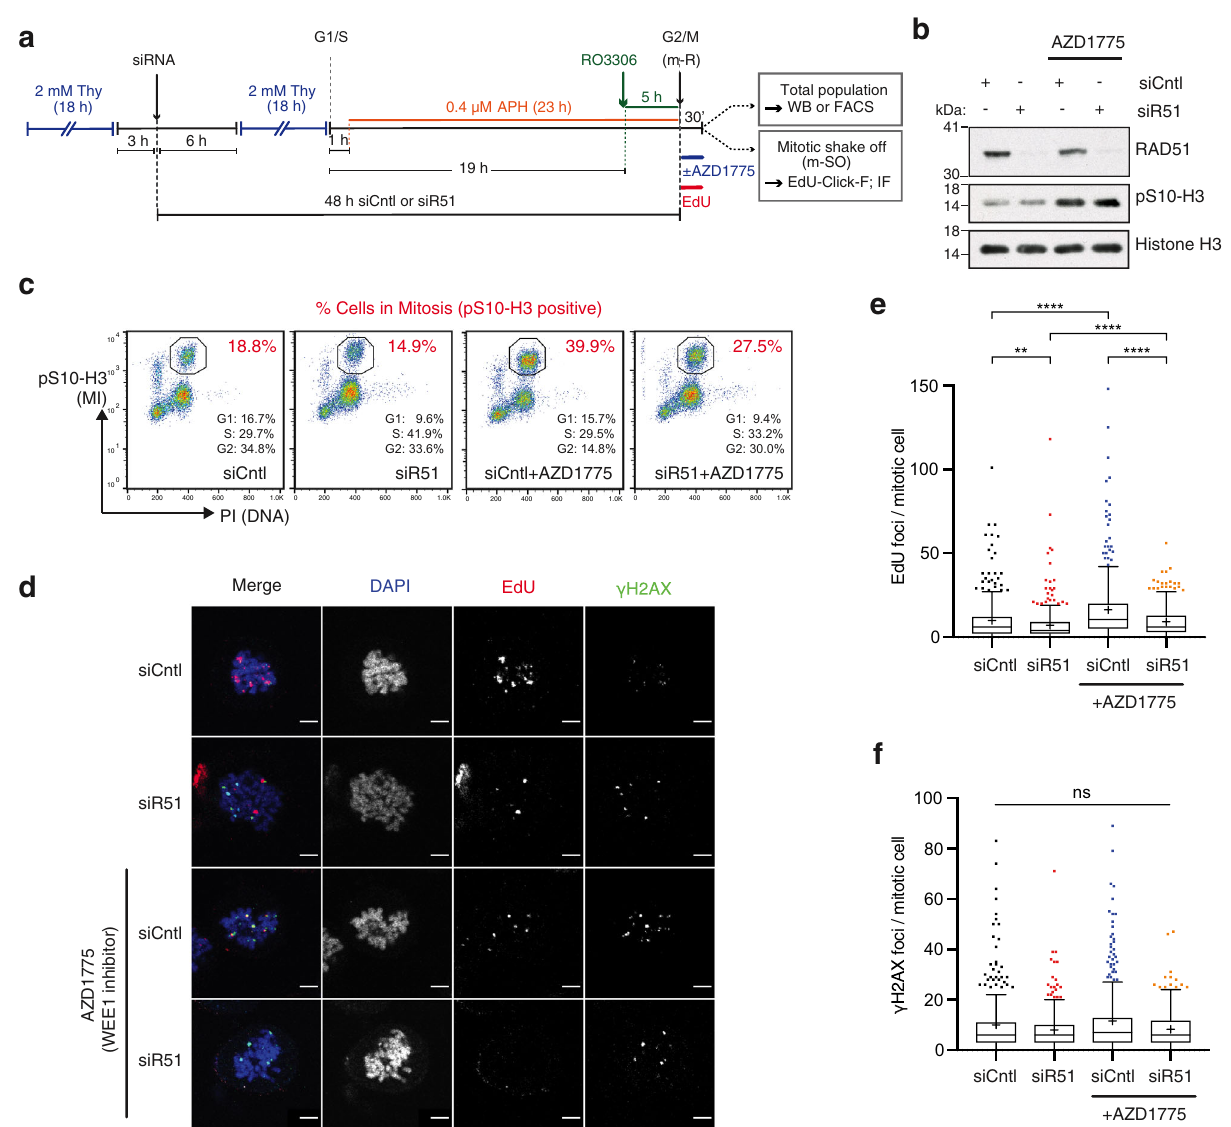
Fig. 1 RAD51 depletion signi fi cantly reduces MiDAS. a Schematic diagram of U2OS cell synchronisation by double thymidine block and release (dT-B/R) with siRNA treatment against RAD51 (siR51) or control (siCntl), followed by exposure to low-dose aphidicolin (0.4 µ M APH) and G2/M arrest by CDK1 inhibitor (9 µ M, RO3306). Cells were released into mitosis (m-R) in medium containing 10 µ M EdU with or without 100nM WEE1 inhibitor (100nM, AZD1775). b , c Western blot analysis against RAD51, mitotic marker pS10-H3 and Histone H3 ( b ) or FACS analysis for mitotic index (MI) (pS10-H3) and DNA content (PI) ( c ) of the total cell population 30min after m-R, according to the work fl ow depicted in a . Based on a single experiment. d Representative images of cells collected by mitotic shake-off (m-SO) at 30min after m-R, stained for EdU incorporation and γ -H2AX and RPA. Scale bar indicates 5 µ m. e , f Quanti fi cation of the number of EdU foci ( e ) and γ -H2AX foci ( f ) per mitotic cell. Data were obtained from three independent experiments (100 cells analysed per repeat); n = 300 per condition. Data distribution is represented by Tukey box-and-whisker plots. Bounds of box are 25 – 75th percentile, centre shows the median and ‘ + ’ marks the mean. Whiskers indicate ±1.5xIQR, data outside this range are drawn as individual dots. p- values were calculated by a Kruskal – Wallis test followed by Dunn ’ s multiple comparison test. Asterisks indicate ** p -value ≤ 0.01; **** p -value ≤ 0.0001. Source data are provided as a Source Data fi